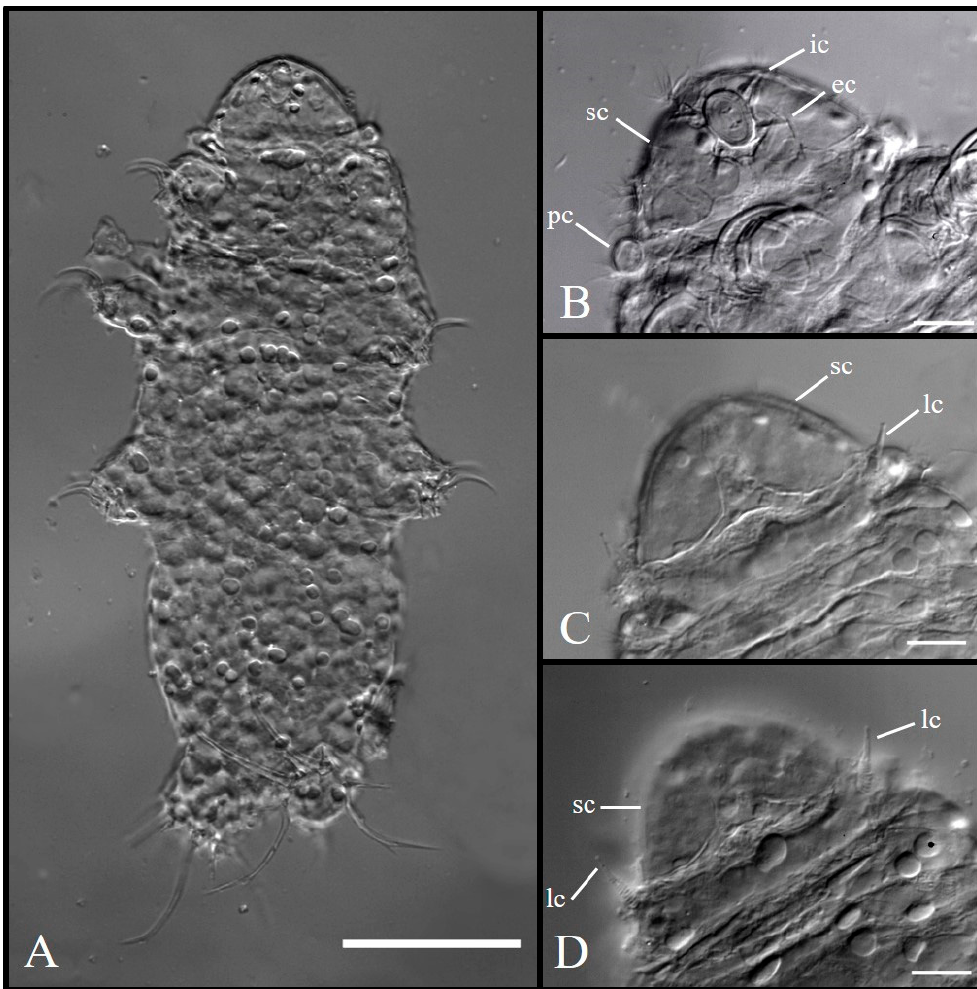
Figure 7. Coronarctus neptunus sp. nov. ( A ) Habitus; ( B ) Ventral view of the head showing the cephalic sensory organs. The ventral lobes of secondary clavae are visible; ( C ) Dorsal view of the head, showing the secondary clavae, primary clavae, and the spherical tip of lateral cirri A ; ( D ) Lateral cirri A , notice the annulated scapi. Abbreviations: ic—internal cirrus; ec—external cirrus; lc—lateral cirrus A ; pc—primary clava; sc—secondary clava. Scale bars: 10 µm.